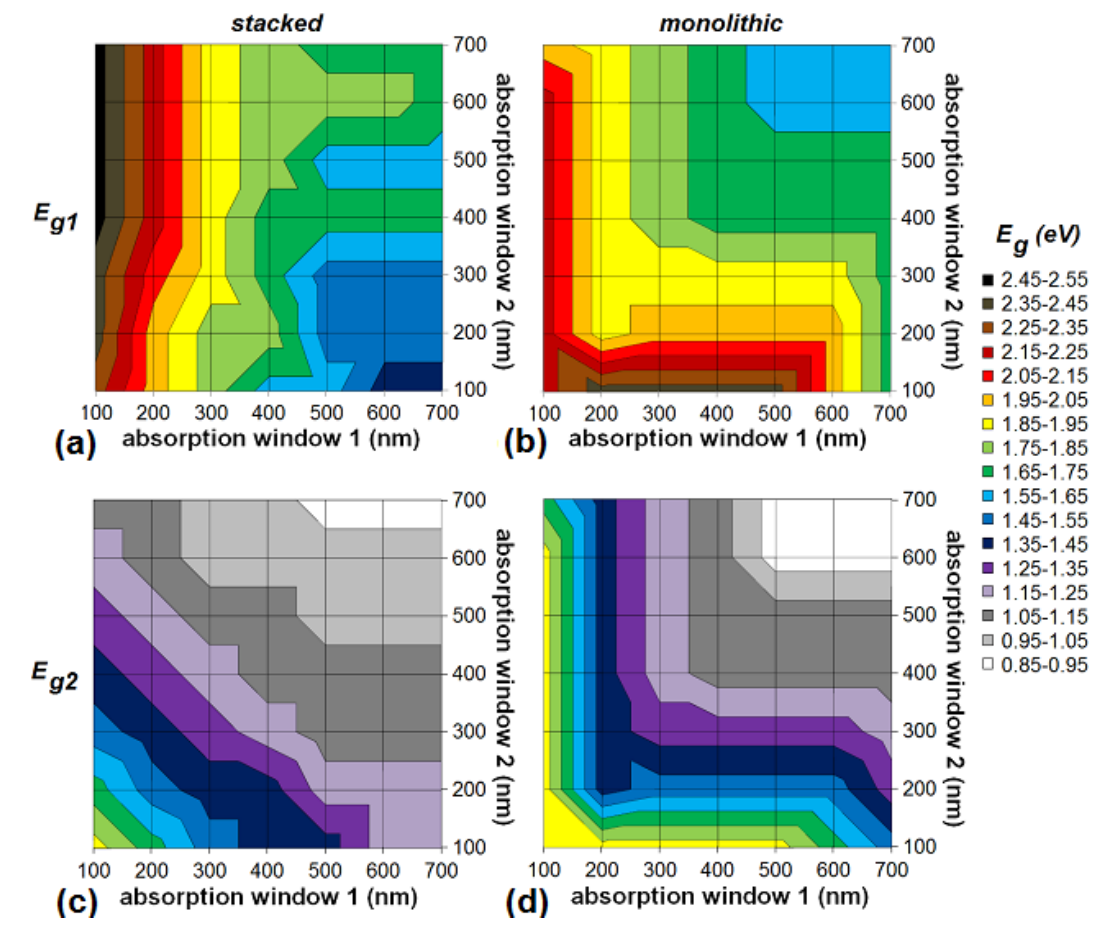
( a , b ) and E ( c , d ) in the ideal scenario for an Figure 11. The optimal bandgaps E g1 g2 organic stacked ( a , c ) and monolithic ( b , d ) tandem cell as a function of the absorption windows of the subcells. “Absorption window 1” refers to the first subcell with the highest absorber bandgap, i.e. , the top cell directed at the